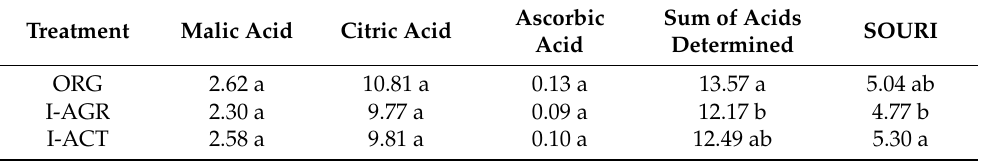
Table 7. Effects of cultivation management on fruit organic acid concentration (mg g − 1 ) and sour